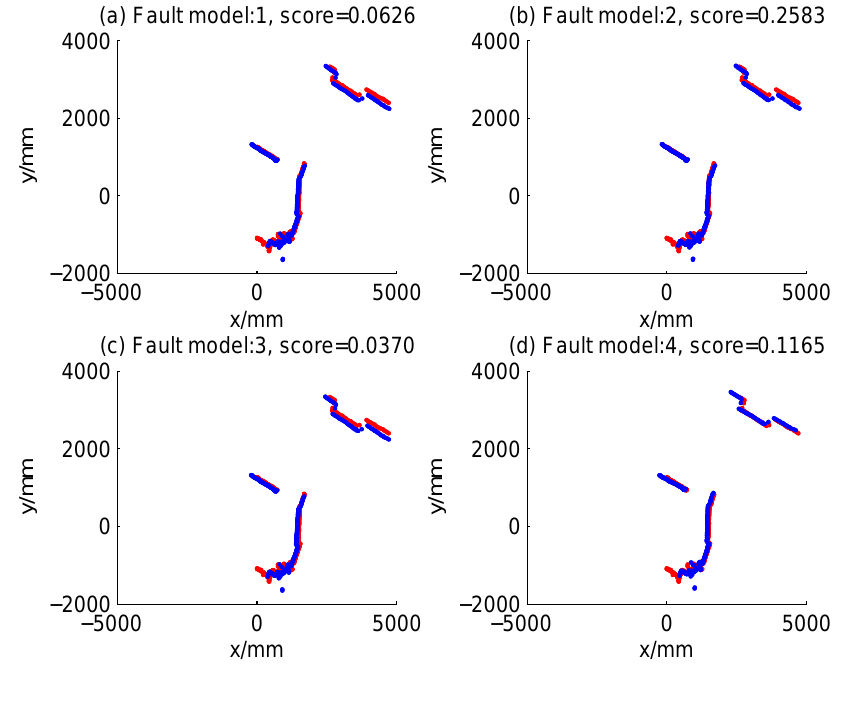
Figure 5. Raw scan match of the initial guess of four fault models (time Step 5).